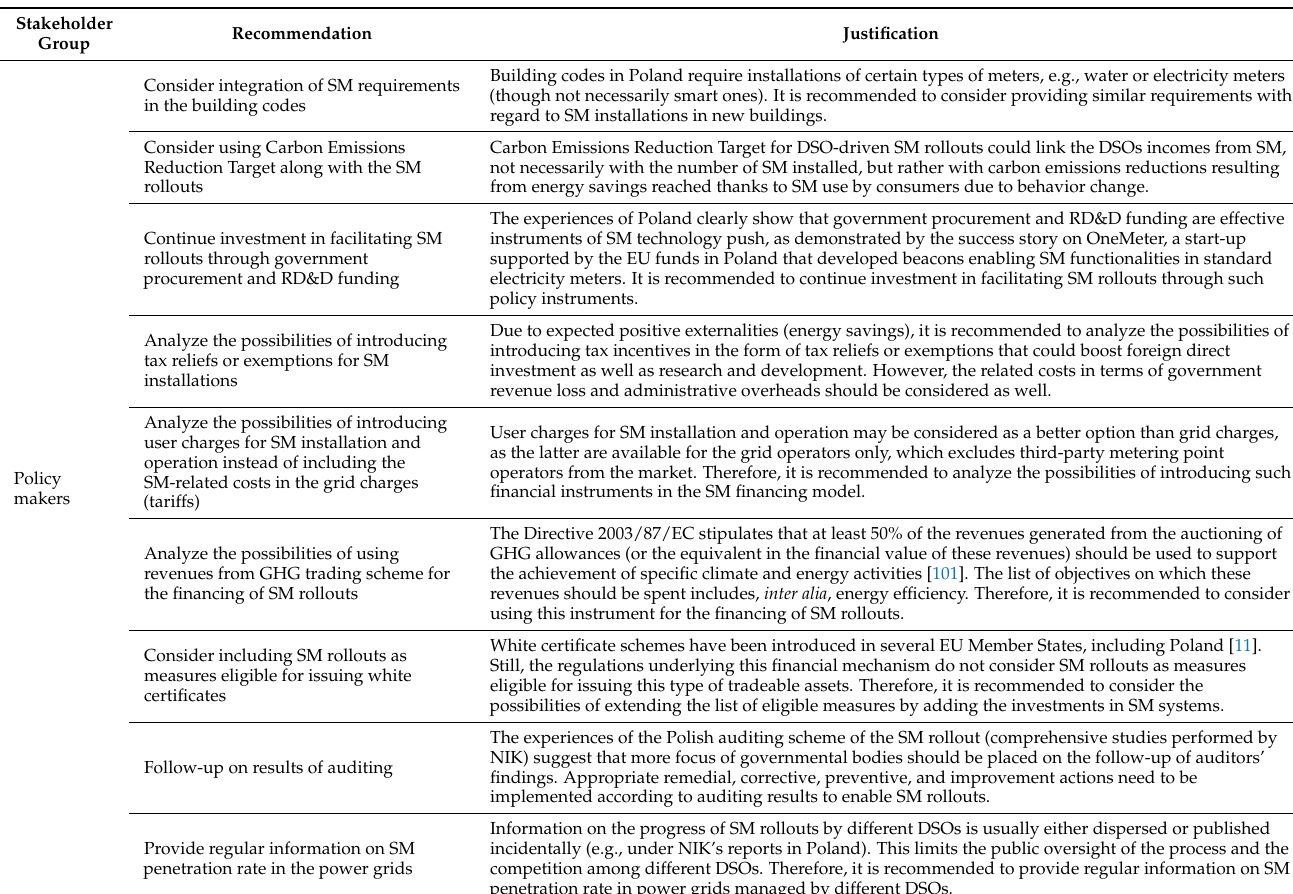
Table 4. Policy and practice recommendations addressing stakeholders of market-driven SM